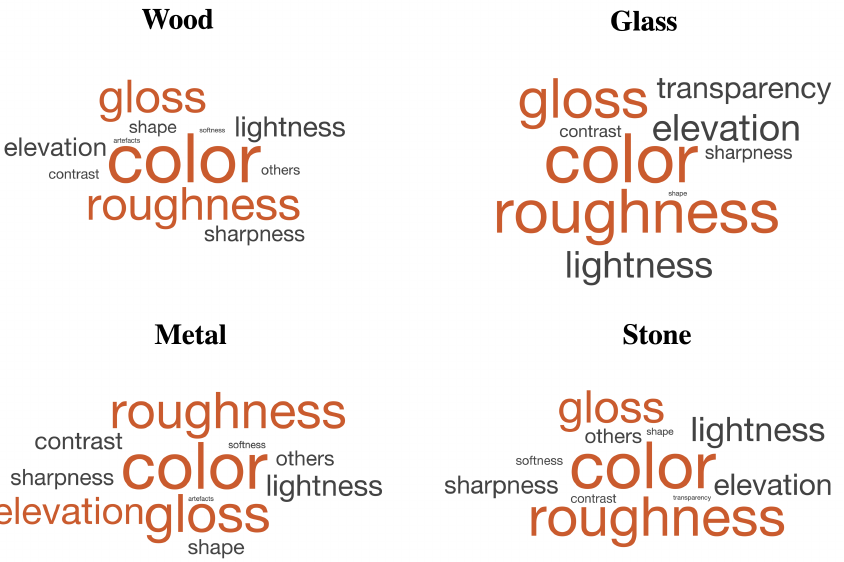
Figure 5. Perceptual attributes used for naturalness assessment of 2.5D prints. The most used attributes have larger areas.